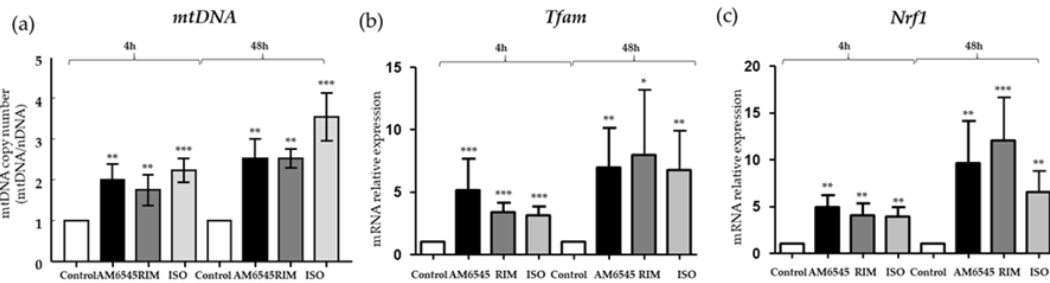
Figure 4. Peripheral cannabinoid receptor 1 (CB1R) antagonist increased mitochondrial DNR (mtDNA) and mitochondrial biogenesis genes. 3T3-L1 adipocytes were treated with AM6545, RIM, and ISO for 48 h. ( a ) AM6545, rimonabant (RIM), and isoproterenol (ISO) increased mtDNA. ( b , c ) Markers of mitochondrial biogenesis, transcription factor A, mitochondrial ( Tfam ), and nuclear respiratory factor 1 ( Nrf1 ), were also increased following treatment with AM6545, RIM, and ISO. Data on graphs are presented as mean ± SEM of 4 independent rounds of the cells; * p < 0.05 vs. control ** p < 0.01 vs. control *** p < 0.001 vs.